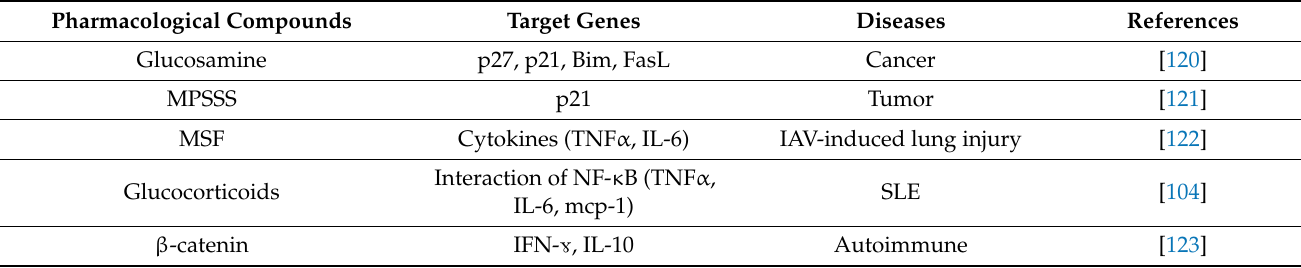
Table 1. Effect of pharmacological compounds in various diseases.